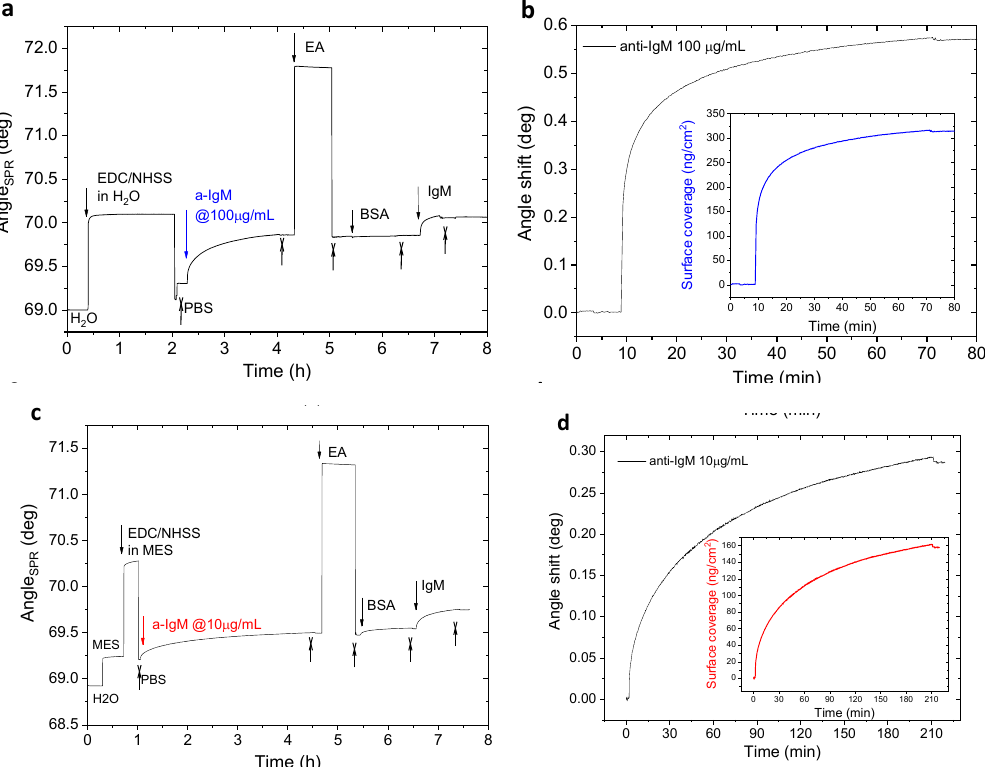
Figure 2. SPR real-time functionalization in which top-down arrows refer to injected solutions and reverse crossed-arrows to phosphate buffered saline (PBS) rinsing steps. ( a ) Sensogram for the immobilization of anti-IgM on the gold surface pre-modified with mixed SAM. ( b ) Zoom of the angular response (angle shift vs time) for anti-IgM exposure at 100 µ g / mL and inset showing the corresponding surface coverage (ng / cm 2 ). ( c ) Sensogram for anti-IgM immobilization performed with reduced antibody concentration and ( d ) zoom in the 10 µ g / mL anti-IgM preconcentration step with surface coverage (ng / cm 2 ) in the inset.